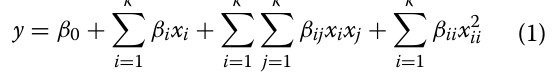
Table 1 Experimental deign levels. Values of independent variables and corresponding coded levels were used in a central composite design Symbols